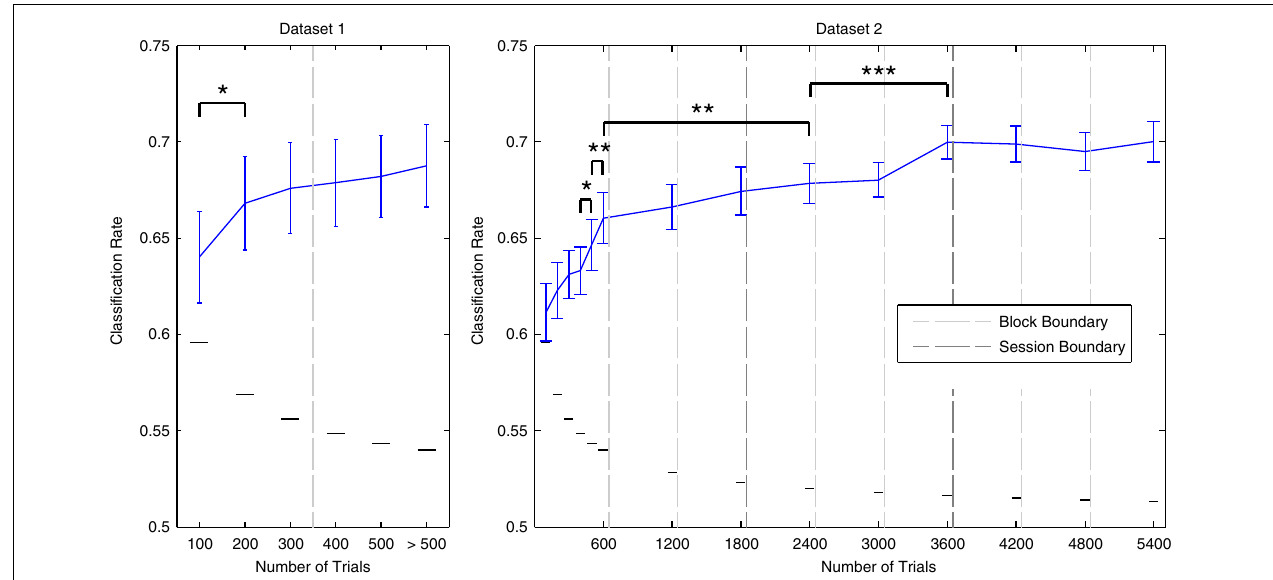
5000.5 100 200 300 400 500 > FIGURE 6 | Effects of dataset size on average cross-validation rates. trials to 200 trials. Performance was highest when using the complete Individual data from Dataset 1 and Dataset 2 were used in incremental steps dataset. For Dataset 2, data from each of the three blocks in each of the to train classifiers on increasingly larger amounts of data. The order in which three measurement sessions were incrementally added to the analysis. the data was collected was preserved. Block/session boundaries are Significant improvements were observed up to the inclusion of 3600 data indicated along with binomial confidence intervals for the maximal number of epochs (i.e., the full data sets from the first and second sessions). From here available data points in each iteration. The amount actually used for some on, average classification performance remained at approximately 70%. Error participants was slightly reduced at certain intervals due to the removal of bars indicate the standard error across participants, while the small horizontal data epochs during the artifact rejection preprocessing step. Data from lines indicate the binomial confidence interval for the maximum number of additional blocks collected for some participants in Dataset 1 were utilized in data epochs that were available. Consecutive pairs of incrementation steps the final iteration. With respect to Dataset 1, a significant increase in for which significant improvements in performance were observed are performance was observed for the initial increase in dataset size, from 100 indicated with brackets and asterisks: ∗ p < 0 . 05, ∗∗ p < 0 . 01, ∗∗∗ p < 0 .